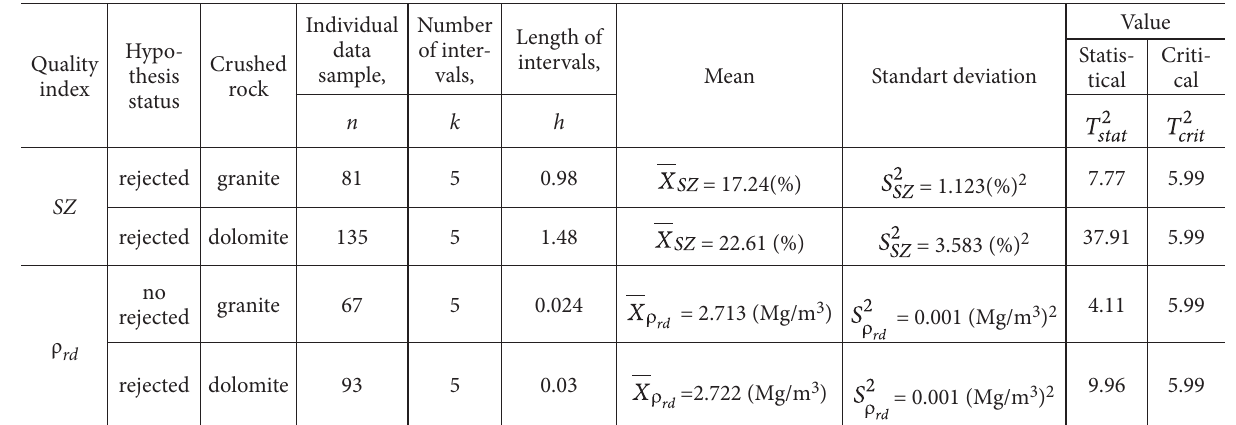
Table 4. Summary of hypotheses on the normal distribution of the values of quality indices